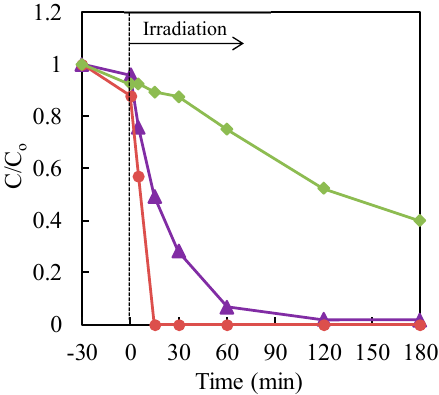
Figure 5. Effect of different commercial TiO 2 on the photocatalytic treatment of Cr(VI) with nanoparticles of TiO 2 in an aqueous solution, in the presence of formic acid hole scavenger. Cr(VI) sample: 30 μ g·mL − 1 (30 mL); TiO 2 : 20 mg (0.67 mg·mL − 1 ). Circle (red): Ishihara Sangyo ST-01; triangle (purple): AEROXIDE® P25TiO 2 ; diamond (green): FUJIFILM Wako Pure Chemical Corp.